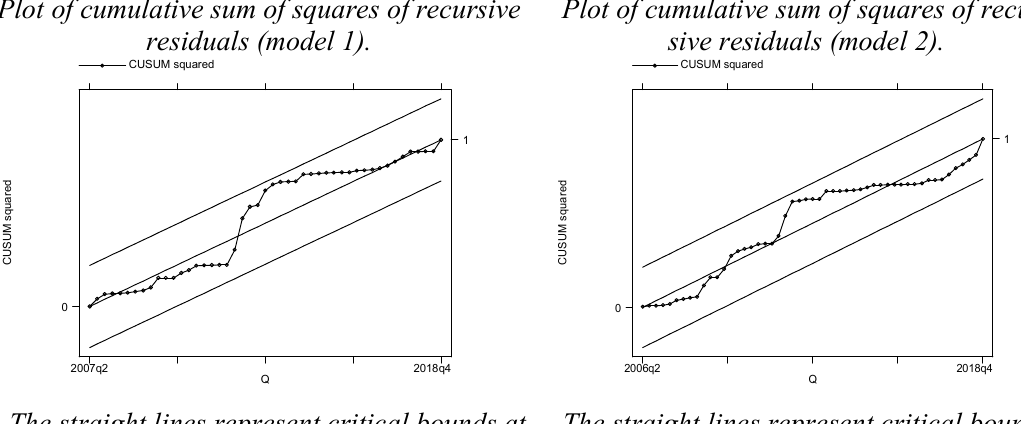
Fig. 3. Plots of CUSUM squared statistics for coefficient stability